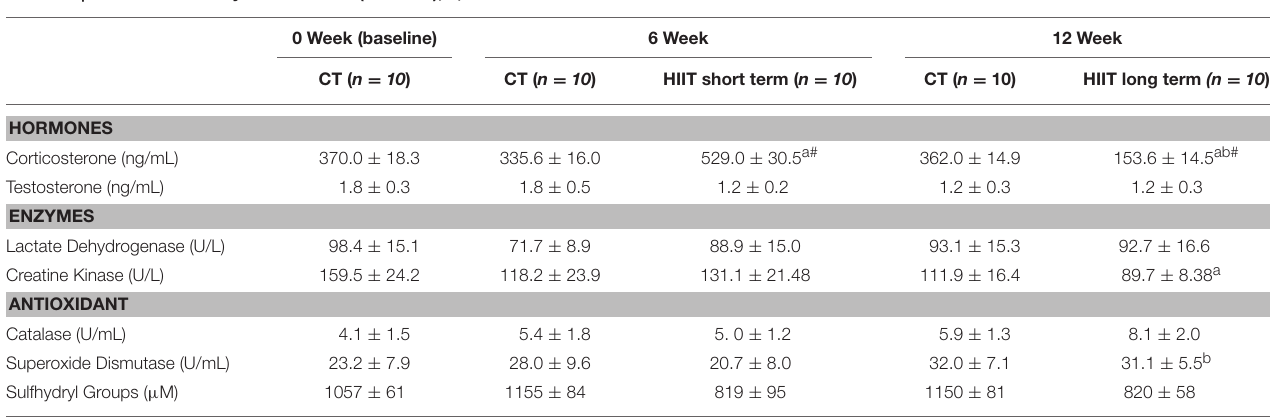
TABLE 1 | Biochemical analyses in 0 week (baseline), 6, and 12